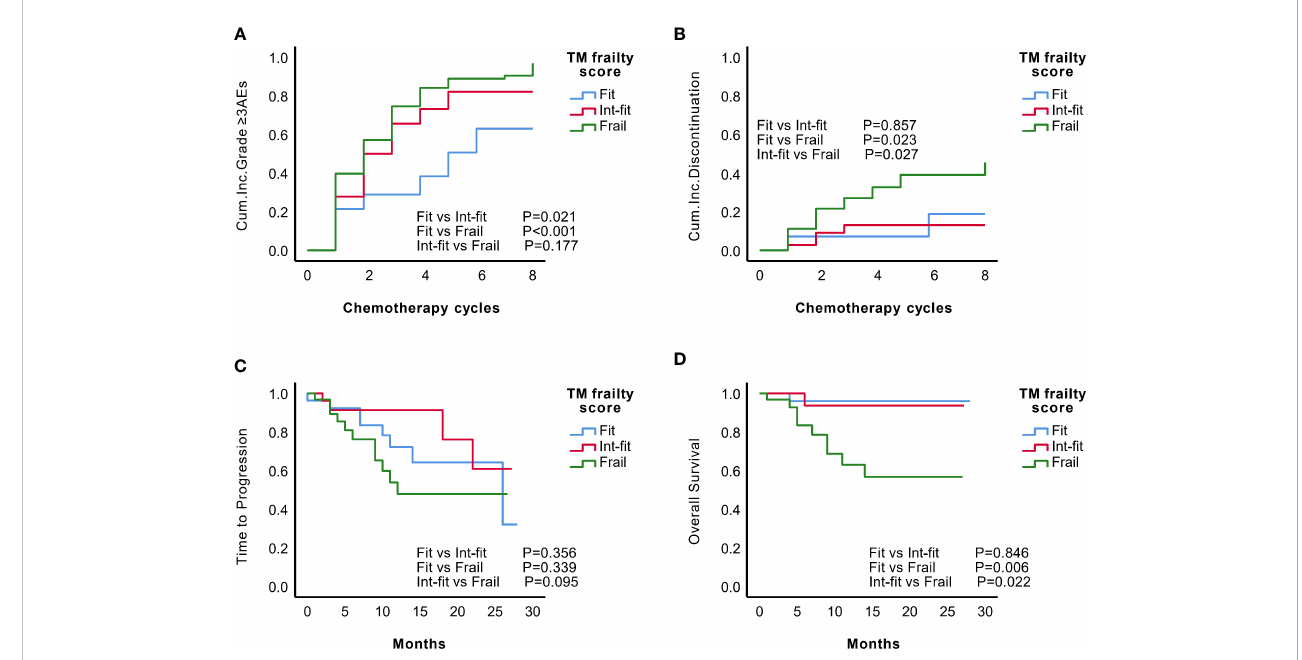
FIGURE 4 Predictive performance of the TM frailty score in the validation set (N=84). KM analysis of the occurrence of grade ≥ 3 AEs (A) and treatment discontinuation (B) according to the TM frailty scores of subgroups in the validation set. There was no signi fi cant difference in TTP (C) between the TM frailty score subgroups. The int- fi t and fi t subgroups showed better OS (D) than the frail subgroup.